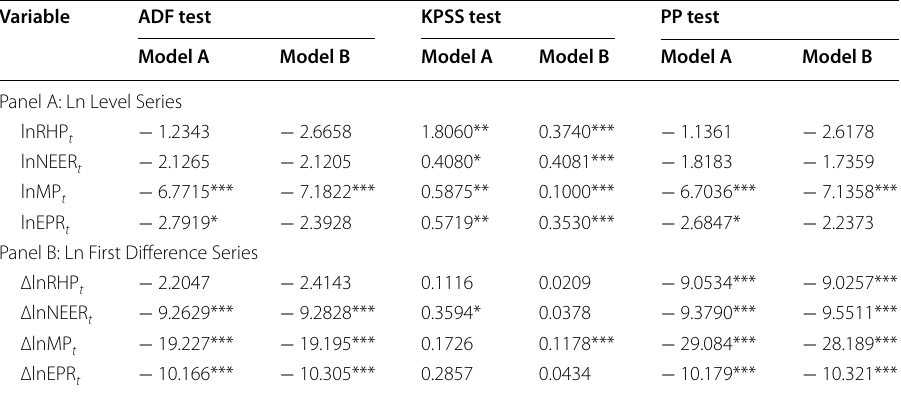
Table 3 Unit root tests